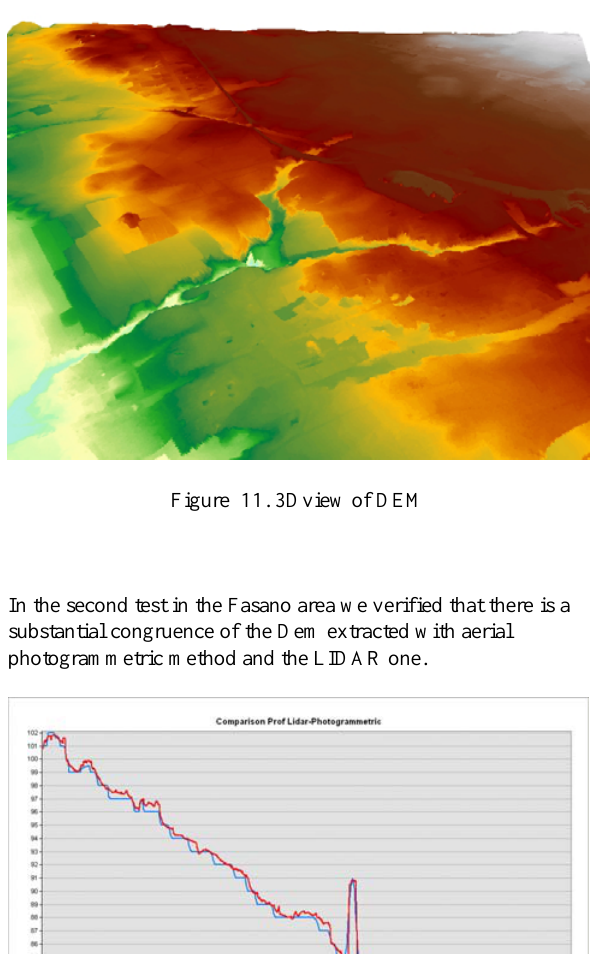
Figure 15. Zoom on new building (test 2)